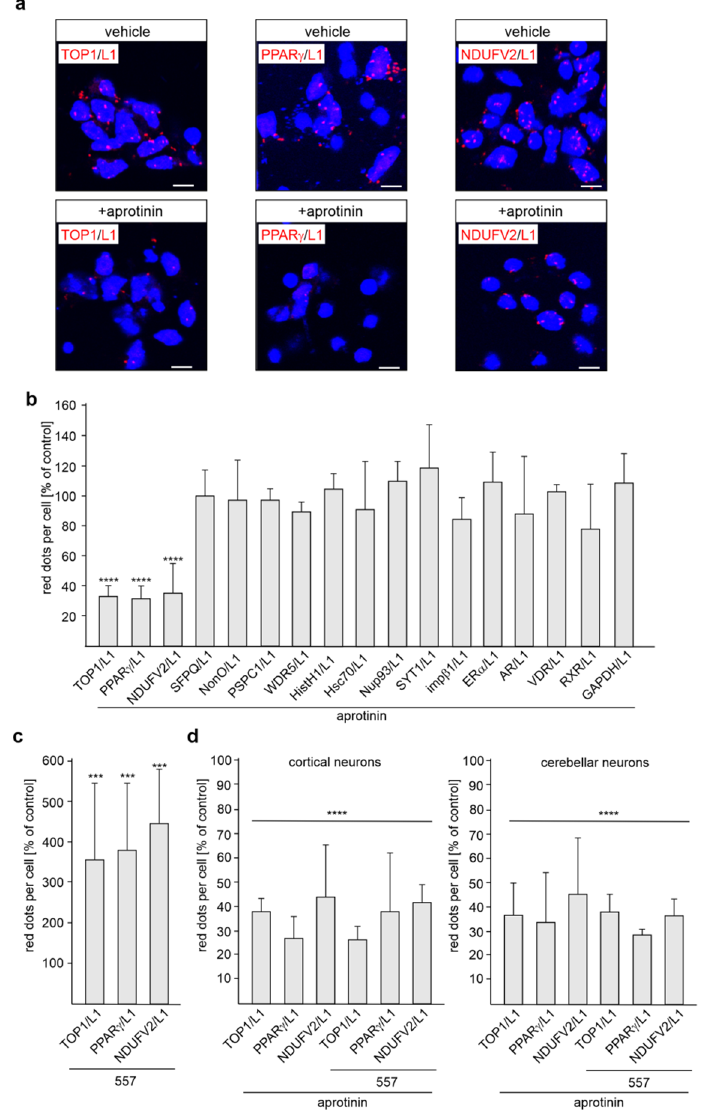
Figure 2. L1-70 interacts with TOP1, PPAR γ and NDUFV2, but not with other L1 binding partners in neurons. Cultured cortical neurons were treated with vehicle (-) or with the serine protease inhibitor aprotinin. They were then subjected to proximity ligation with L1 antibody and antibodies against SFPQ, NonO, PSPC1, WDR5, TOP1, HistH1, Nup93, Hsc70, SYT1, imp β 1, ER α , RXR, PPAR γ , NDUFV2, AR, VDR or GAPDH. ( a ) Representative images of vehicle- and aprotinin-treated neurons stained with the mouse L1 antibody C-2 and rabbit antibodies against TOP1, PPAR γ or NDUFV2 are shown. Nuclei are stained with DAPI. Scale bars: 10 µ m. ( b ) Mean values + SD from two independent experiments are shown for the average numbers of red dots per cell relative to control (values of vehicle control set to 100%) (**** p < 0.001; one-way ANOVA with Bonferroni’s multiple comparison test). ( c ) Cortical neurons were treated with or without L1 antibody 557. Mean values + SD from two independent experiments are shown for the average numbers of red dots per cell relative to control (values of treatment without antibody 557 set to 100%). (*** p < 0.005; one-way ANOVA with Bonferroni’s multiple comparison test). ( d ) Cortical and cerebellar neurons pretreated with vehicle or aprotinin were incubated without or with antibody 557 in the absence or presence of aprotinin. Mean values + SD from two independent experiments are shown for the average numbers of red dots per cell relative to control (values of treatments without aprotinin set to 100%) (**** p < 0.001; one-way ANOVA with Bonferroni’s multiple comparison